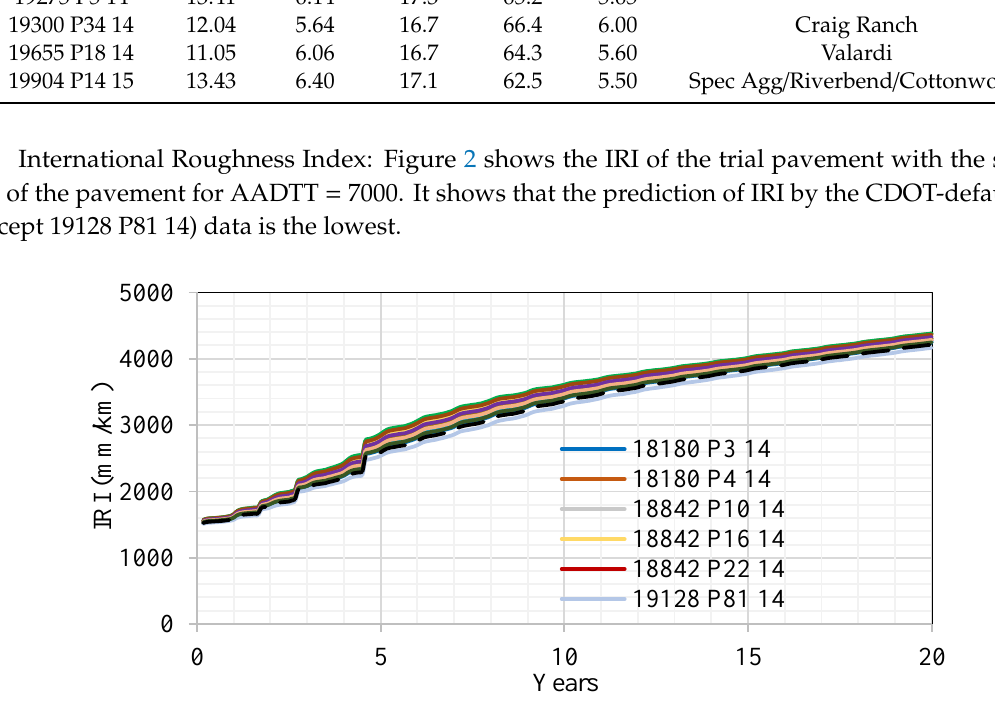
Figure 2. International roughness index (IRI) due to AADTT = 7000 by SX (100) PG 64-22 mix. Total Rutting: Figure 3 shows the total rutting of the trial pavement with the service life of the pavement for AADTT = 7000. It shows that the prediction of total rutting by the CDOT-default mix (except 19128 P81 14) data is the lowest. This means the CDOT-default dynamic modulus data for the PG 62-22 binder predicts a lower rutting compared to that of the actual tested dynamic modulus (except for 19128 P81 14). Comparing contractor to contractor, the prediction varies a lot. For example, if the threshold total value is 15 mm (0.6 in.), then the prediction reaches the threshold from four years to nine years. The statistical analysis shows that several mixes are within the 95% Confidence Interval (CI)